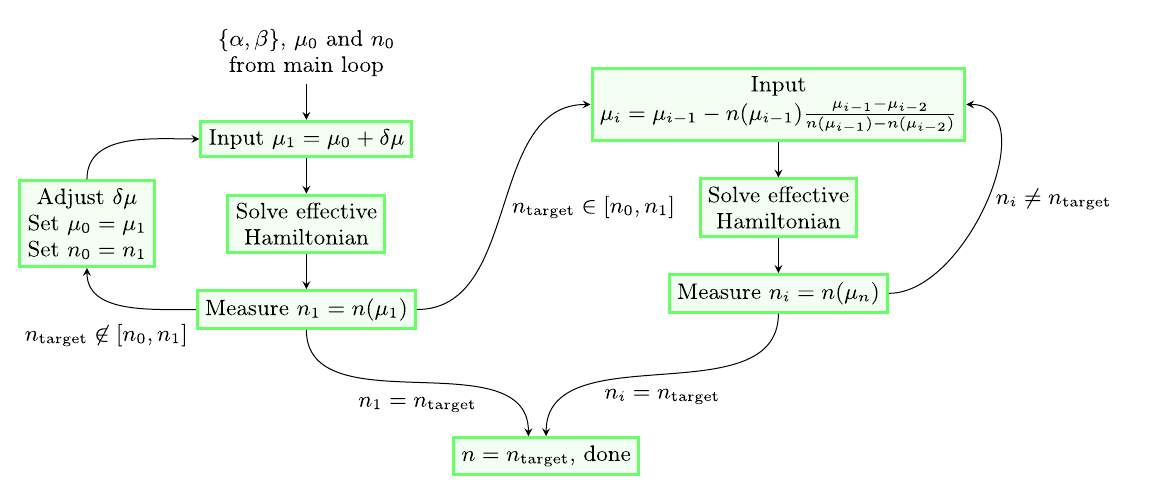
FIG. 8. Schematic representation of the density-fixing routine. Chemical potential at different stages of the loop are named μ and density n i